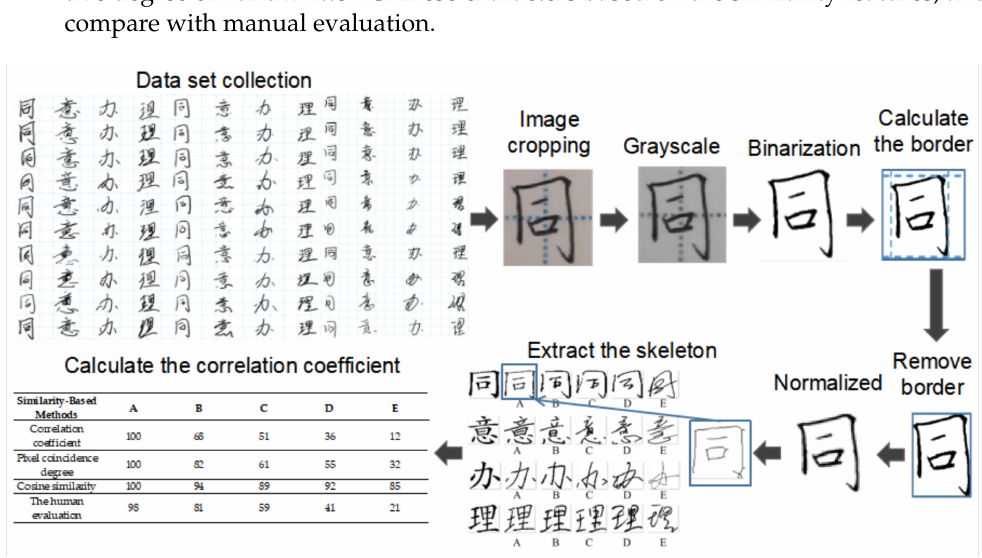
Figure 1. Image of Chinese characters “ 同 意 办 理 ” (means “agree to proceed”) processing